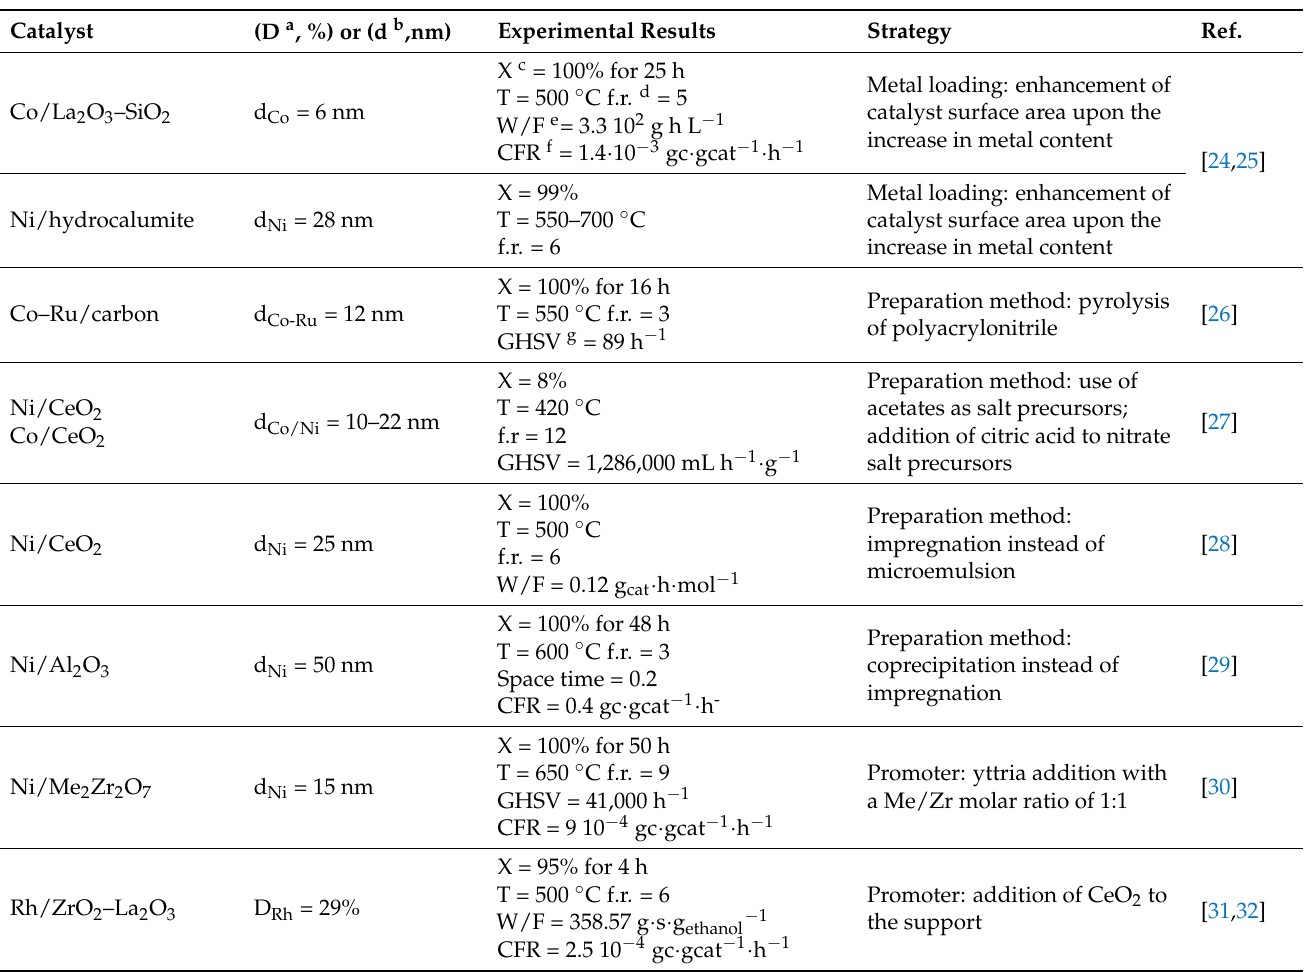
Table 1. Different approaches found in the recent literature to enhance particle dispersion and increase catalyst stability during ethanol reforming. Experimental